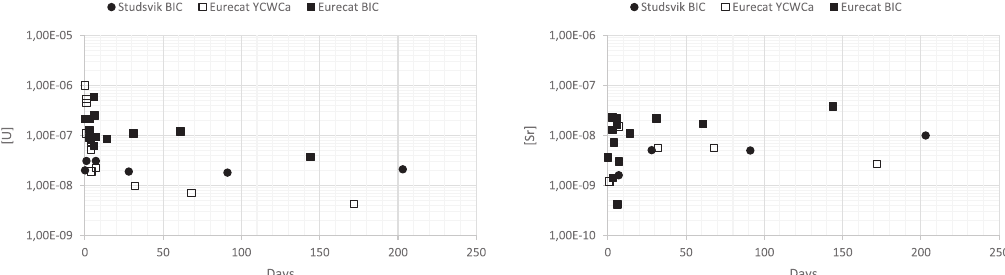
Fig. 7. Concentration in aqueous solution vs. time for standard fuel leaching in bicarbonate (BIC) water and Young cement water with Ca (YCWCa), both with hydrogen overpressure (Studsvik: initially 50 bar hydrogen. Eurecat: initially 35 bar with 1,7 bar hydrogen). NB for the Studsvik dataset, only data up to ∼ 200 days are shown. Data produced by Studsvik and Eurecat in the DisCo